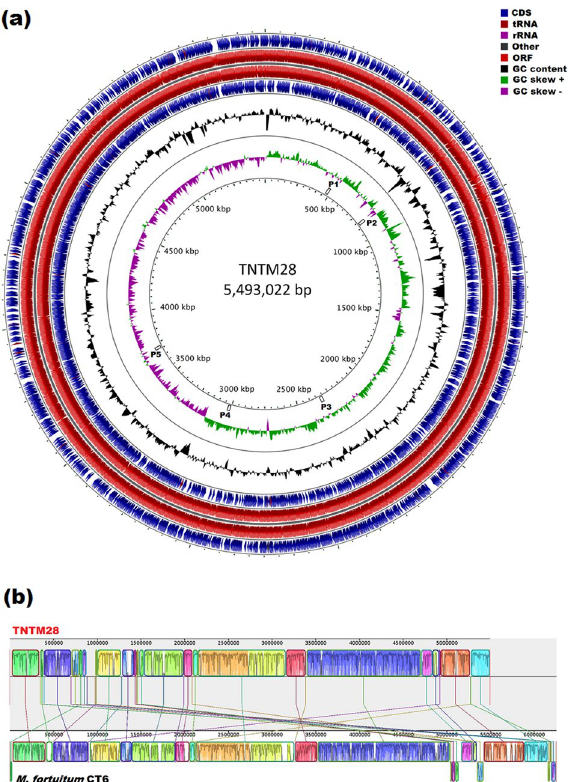
Figure 2. Graphical map of TNTM28 genome. ( a ) Circular map of the 5.49 Mb TNTM28 chromosome performed with GCview Server. The circles represent, from outside to inside: rings 1 and 4 show protein- coding genes oriented in the forward and reverse orientations, respectively. Rings 2 and 3 display genes on forward and reverse strand, respectively. Ring 5 shows G + C% content plot (black). Ring 6 shows GC skews, with positive and negative values being indicated with green and purple colors, respectively. Positions of the prophage regions (P1 to P5) are indicated in the innermost circle. ( b ) Genome alignment performed using Mauve software between TNTM28 with its closest species, M. foruitum , strain CT6. Boxes with identical colors represent locally collinear blocks (LCBs), indicating homologous DNA regions shared between the two genomes without sequence rearrangement. Lines collate aligned segments between genomes. The vertical bars denote the conservation level, and upward and downward orientations relative to the genome line indicates collinear and inverted regions, respectively. Sequences outside colored blocks do not have homologs in the other genome. Red lines indicate contig boundaries within the